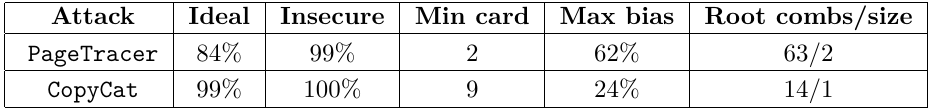
Table 3: mbedTLS combination